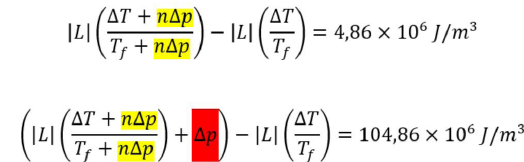
Figure 4. Comparison between the magnitude of the pressure effect proposed in the literature and that proposed in this work.